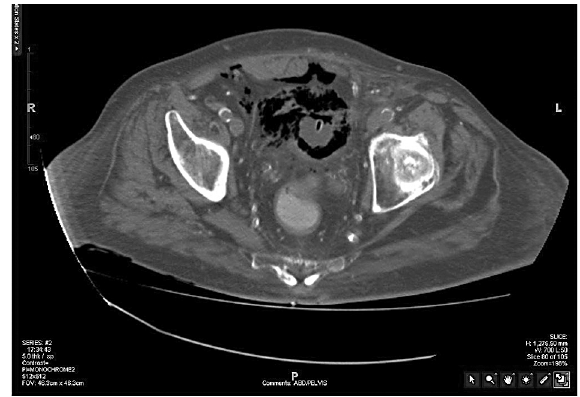
Figure 2 – Gas is dissecting anteriorly into the space of Retzius and laterally toward the abdominal wall and inguinal fossa. Note tissue debries outlined by gas in the bladder and a soft tissue mass (ileal loop) indenting the bladder.